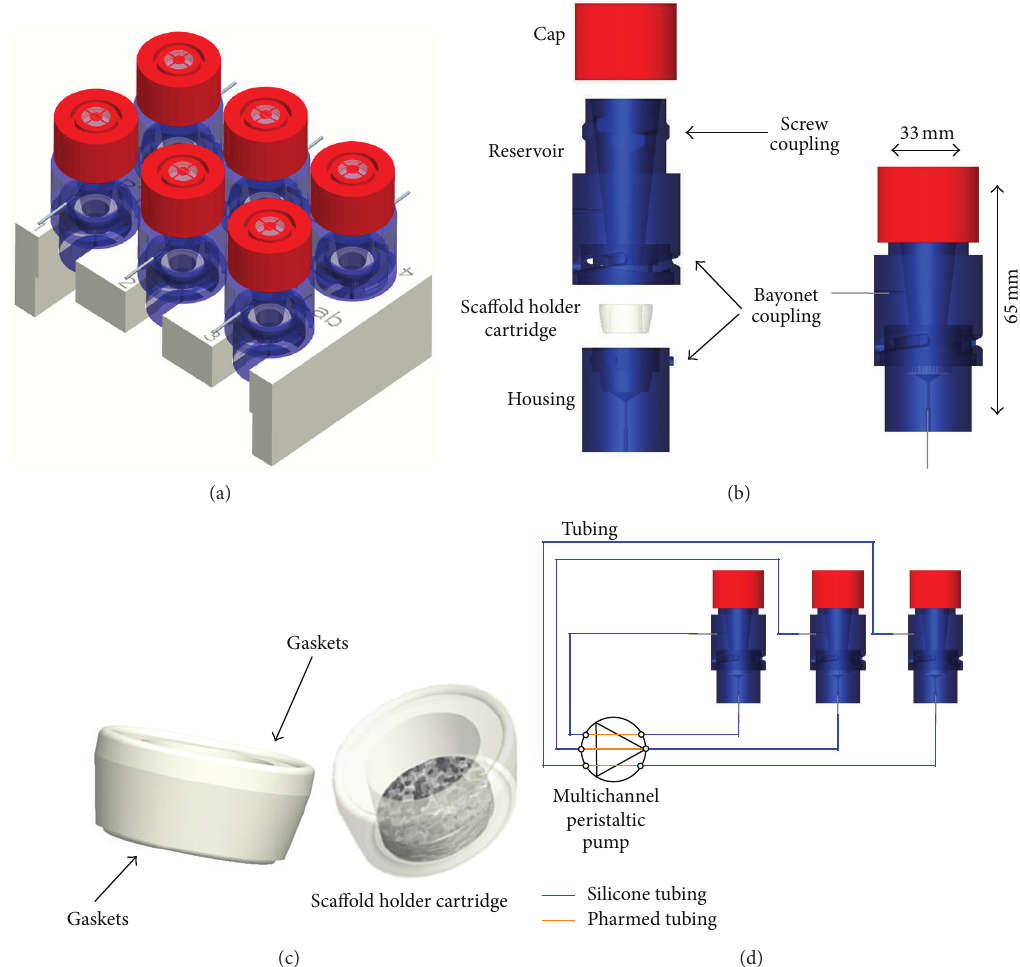
Figure 1: CAD model of the six-chamber bioreactor (a). CAD model of the single culture chamber: exploded and assembled view; the culture chamber is composed by a reservoir, a disposable screw cap, a housing, and a scaffold holder cartridge (b). Detail of a scaffold holder cartridge with a 10mm opening diameter; the arrows indicate the upper and lower gaskets; the cartridge allows hosting matrices with different sizes and shapes (c). Sketch of the fluidic circuit with parallel culture chambers and perfusion circuits, actuated by a multichannel peristaltic pump (three out of six parallel circuits /chambers are shown)